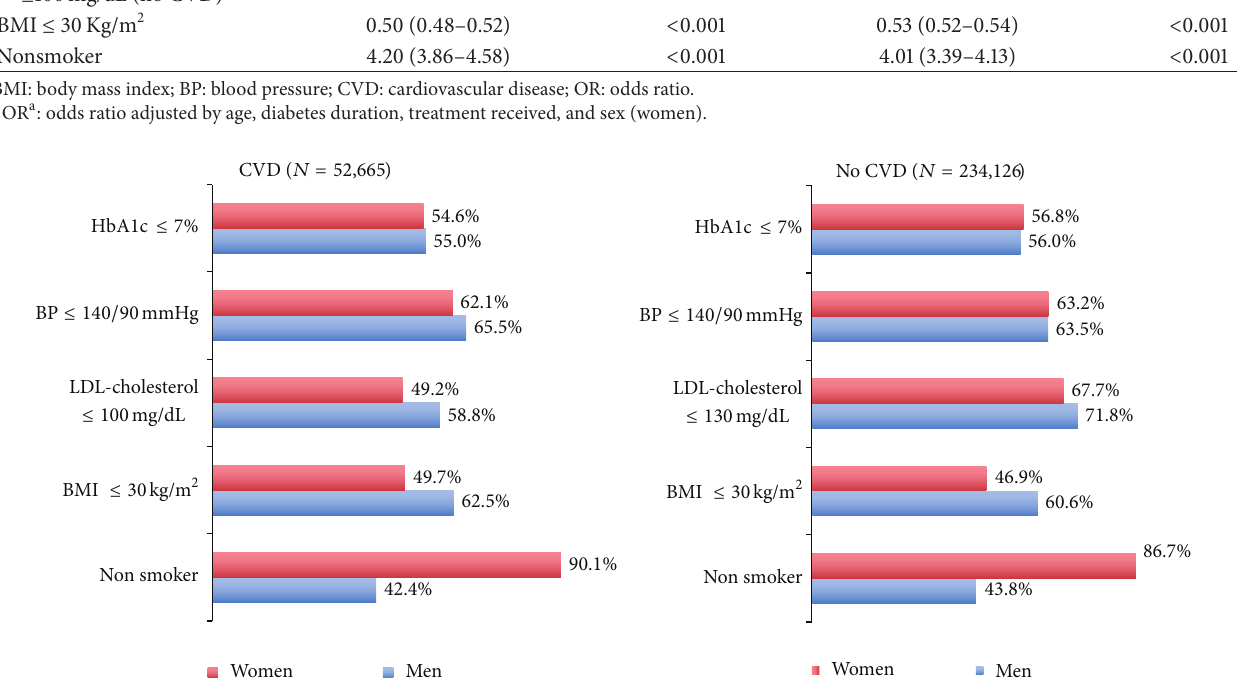
Figure 1: Percentage of patients with T2DM and good control of CVRF by gender and history of CVD (all variables showed significant differences between sexes ( 𝑃 < 0.005 ) and between CVD and no CVD in both men and women ( 𝑃 < 0.001 ), except for HbA1c: 𝑃 = 0.058 in men and 𝑃 = 0.003 in women. BMI, body mass index; BP, blood pressure; CVD, cardiovascular